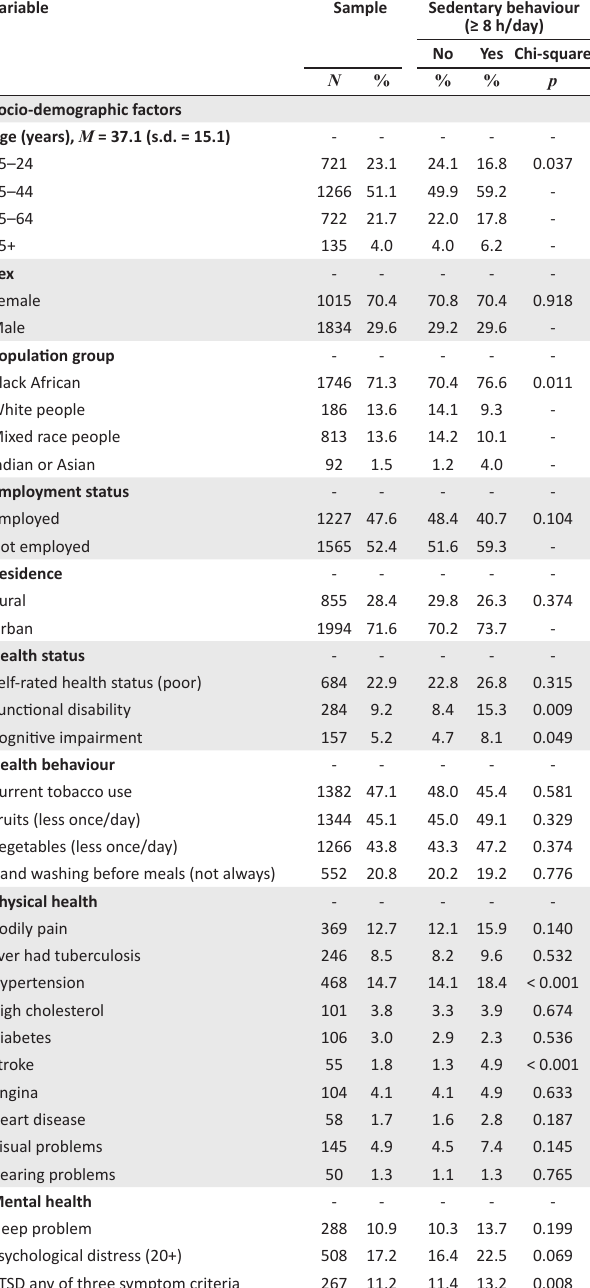
TABLE 1: Sample characteristics and prevalence of high sedentary behaviour among problem drinkers ( N = 2849). Variable Sample